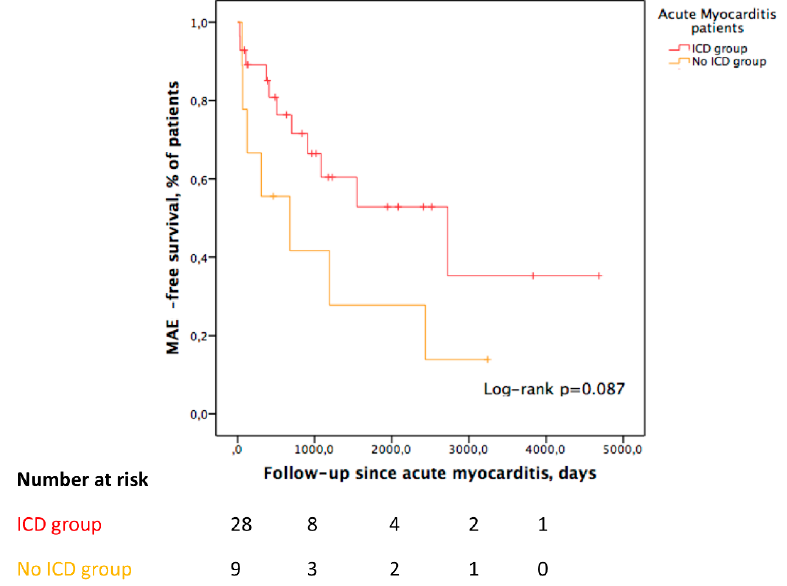
Figure 4. Kaplan–Meier curve comparing survival without major arrhythmic events in acute Figure4. Kaplan–Meiercurvecomparingsurvivalwithoutmajorarrhythmiceventsinacutemyocarditis myocarditis patients with and without an ICD . patients with and without an